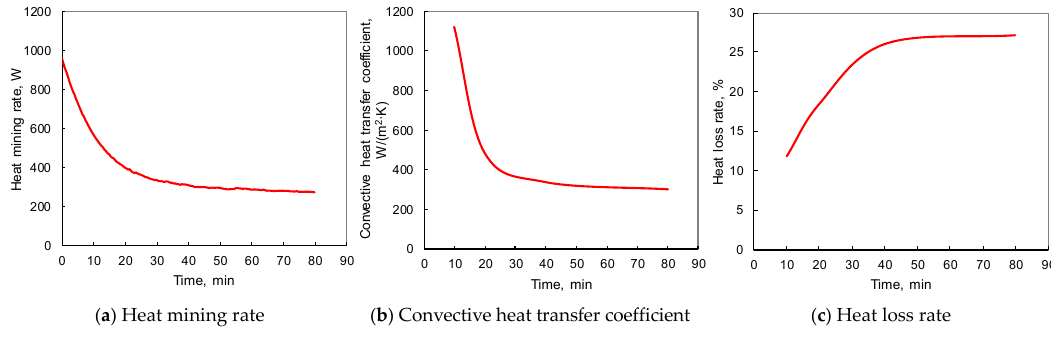
Figure 4. The main heat exchange parameters of the heat exchange tube with time.